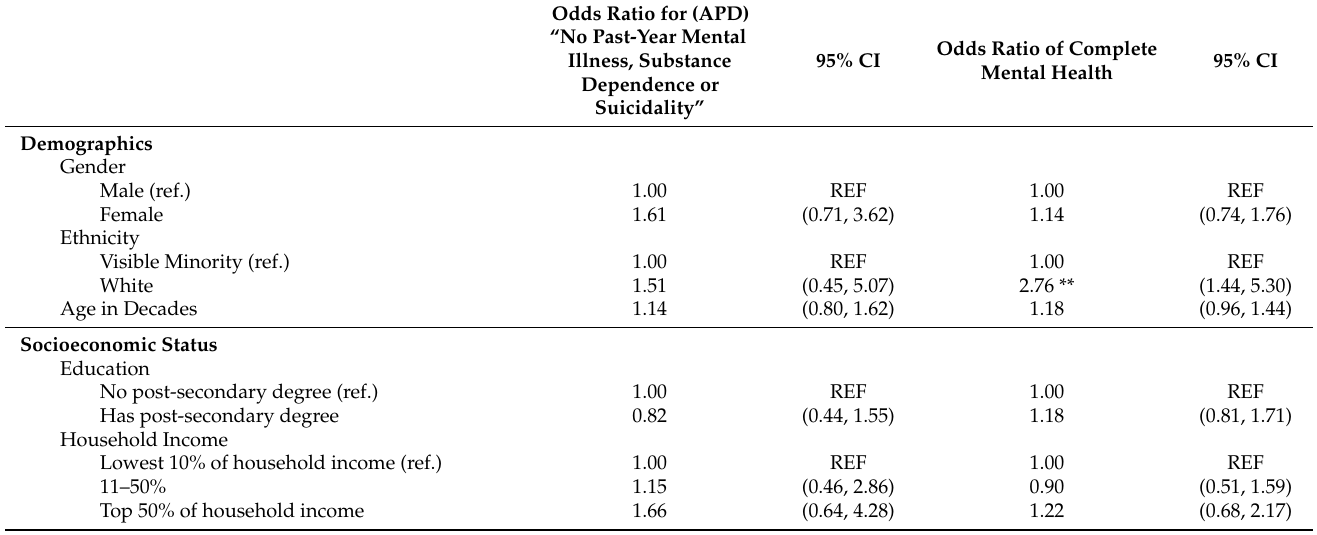
Table 2. Odds ratio and 95% Confidence Intervals of Absence of Psychiatric Disorders (APD) and Complete Mental Health (CMH) in Past Year for Those with a History of COPD in a Population- based Sample of Canadians aged 50 and Older ( n = 703). Source: Canadian Community Health Survey-Mental